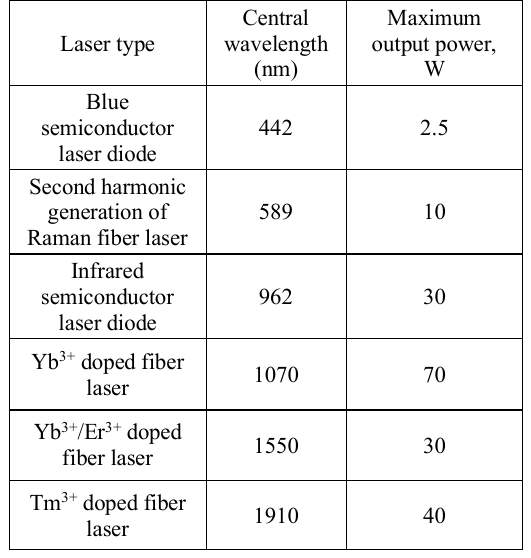
Table 2. Main parameters of the employed laser radiation sources.